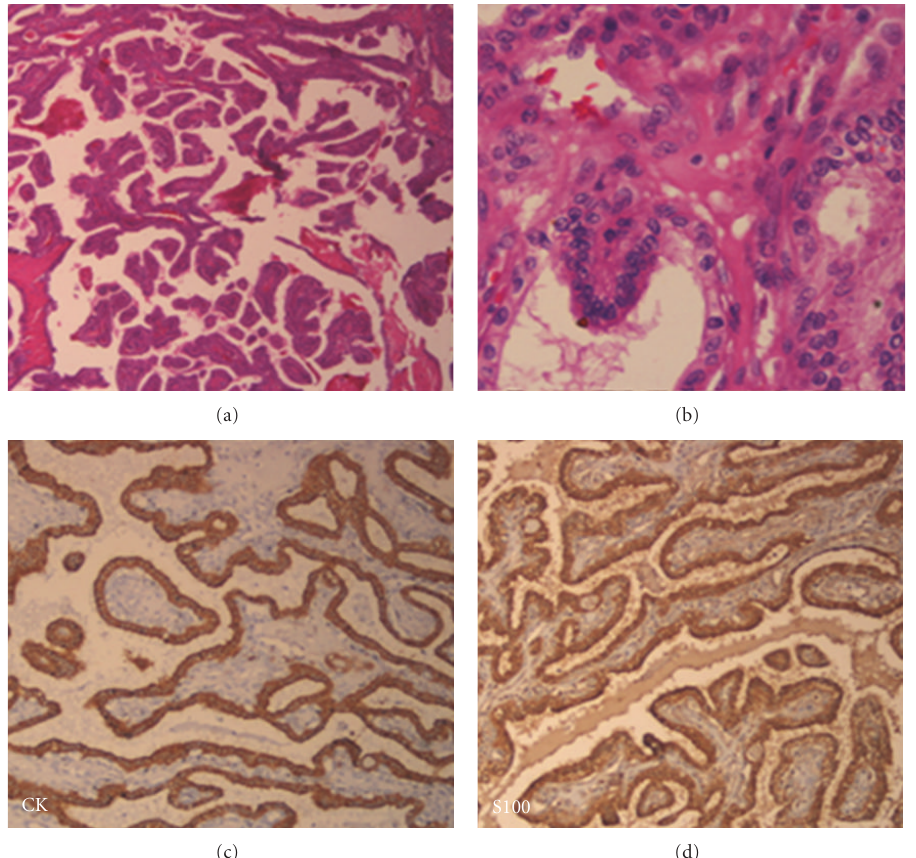
Figure 2: Microscopy shows typical papillary structures (2(a), H&E × 100), lined by benign looking low cuboidal epithelial cells (2(b), H&E × 200). Tumor cells are immunopositive for cytokeratin (2(c), IHC (CK)[Daco] × 200) and S100 (2(d), IHC (S100)[Daco] ×